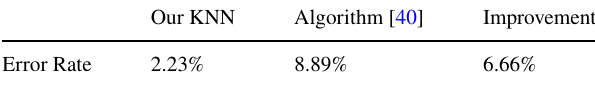
Table 13 Error rate comparison on 20 simulated